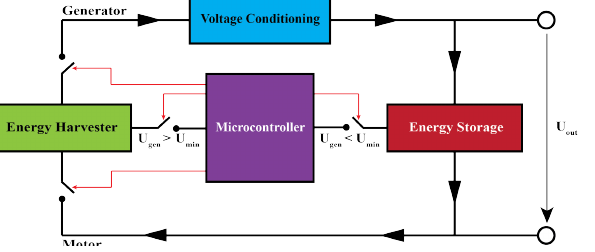
Figure 3. Values of ϕ for which the transfer of vibrational energy is maximized.